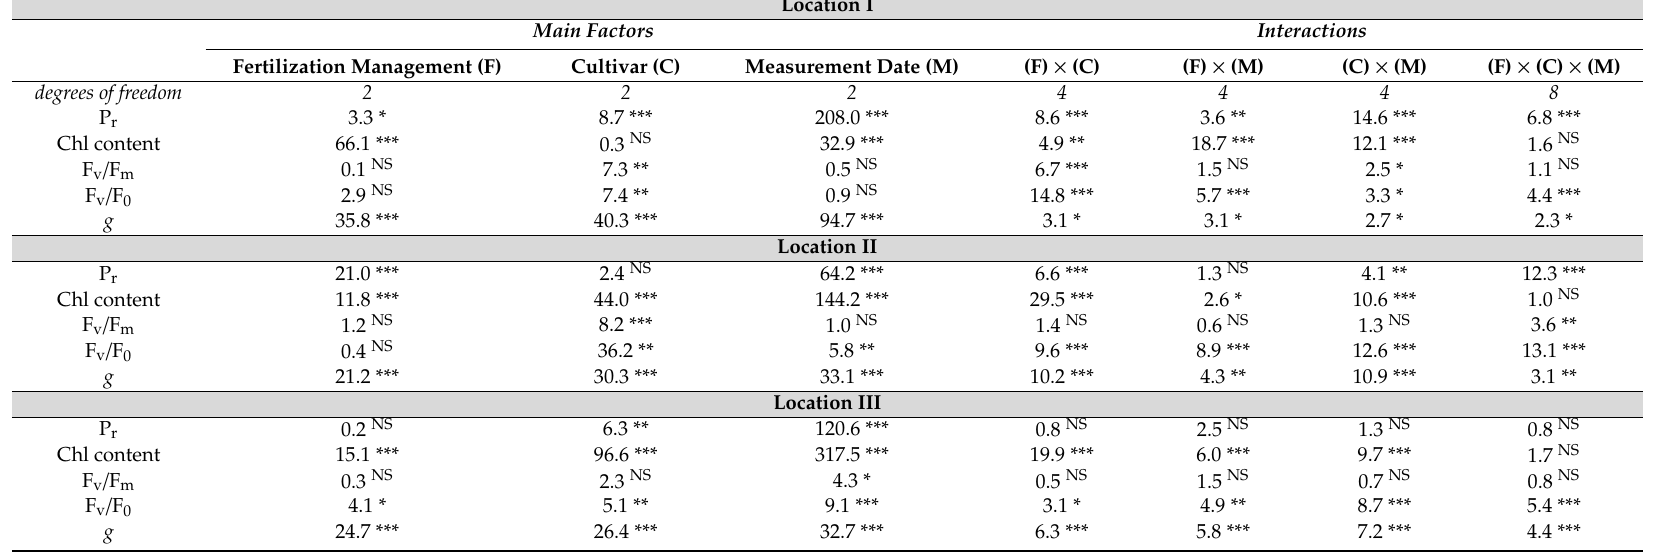
Table 4. F -values as absolute value of main factors and their interactions resulting from ANOVA of photosynthesis rate (Pr), chlorophyll content (Chl), Chl fluorescence parameters and stomatal conductance ( g